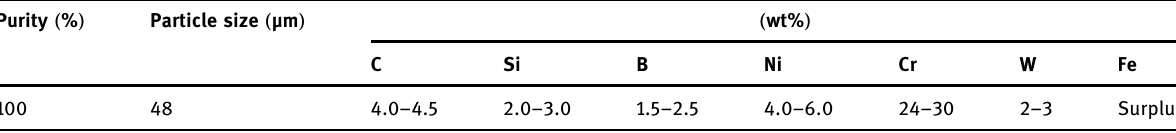
Table 2: Characteristic parameter of Fe60 powder Purity ( %